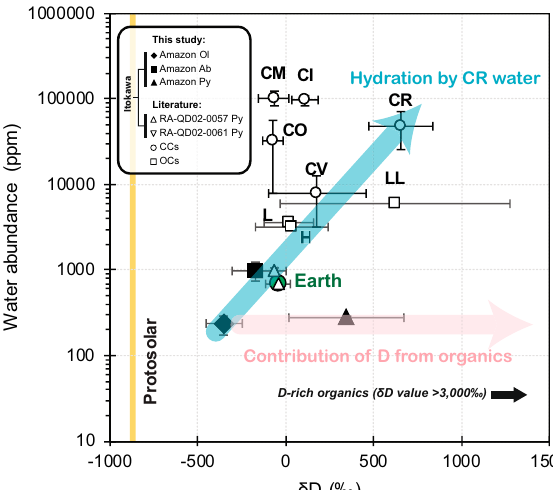
Figure 4. Water contents of NAMs in Amazon compared to water on bulk silicate of Earth, chondritic material and protosolar. Data indicated by closed black symbols are from this study. Error bars are 2 sigma errors. The blue arrow indicates the change in water abundance and δD value from the initial value (recorded by Itokawa olivine), towards values reported for water in Itokawa albite (this study), Itokawa pyroxene reported by Jin and Bose 15 , and Earth, by the incorporation of CR water. With a δD value of + 4868‰, organic material increases the δD value of the organic-bearing pyroxene in Amazon following the pink arrow. Literature Itokawa pyroxene data are from 15 , chondritic data are from 18 and references